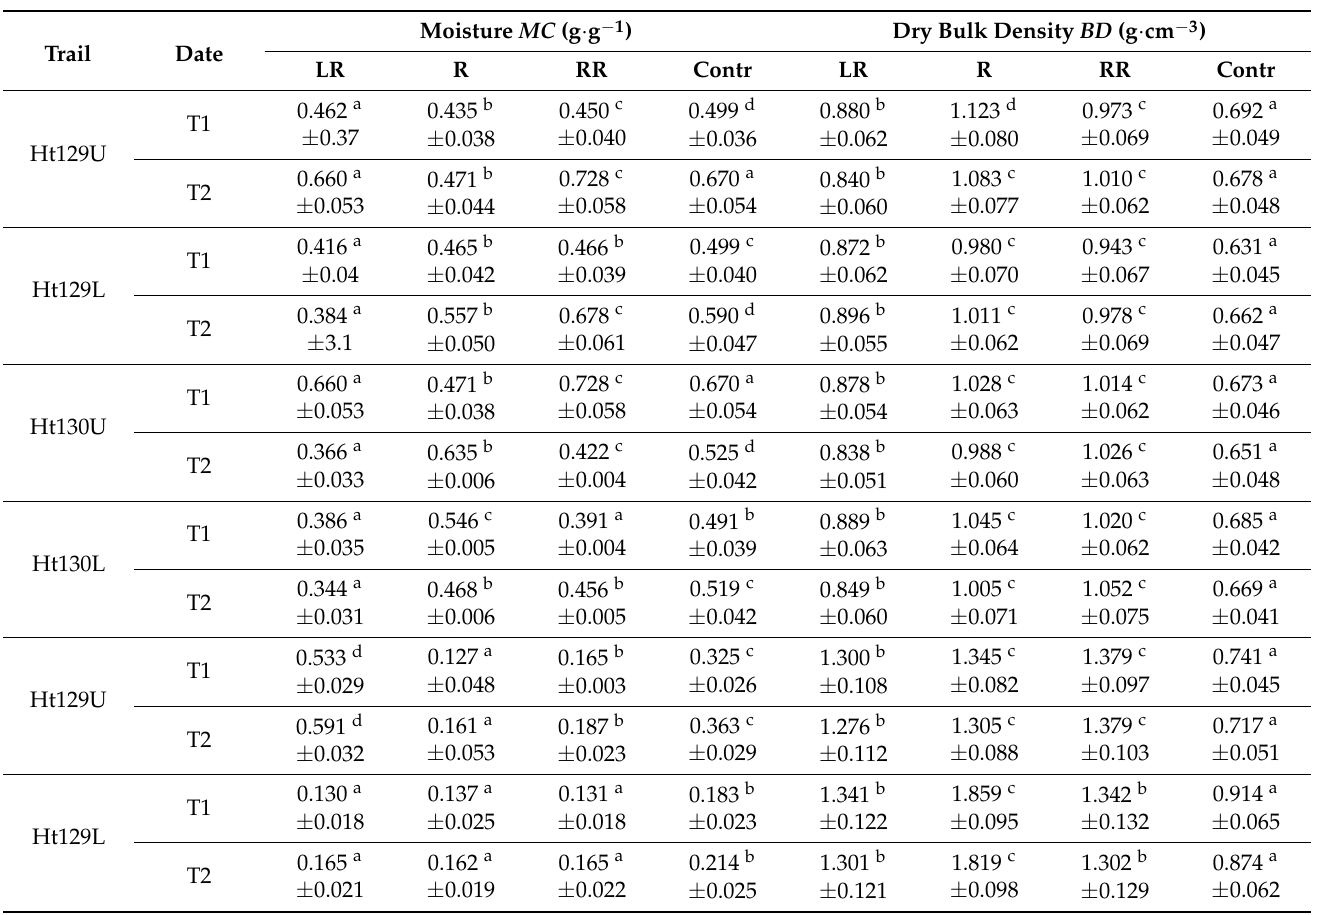
Table 3. Mean ( ± SD) current soil moisture and dry bulk density in trails and control plots (superscript a–d: homogeneous groups determined by Tukey’s test, p <